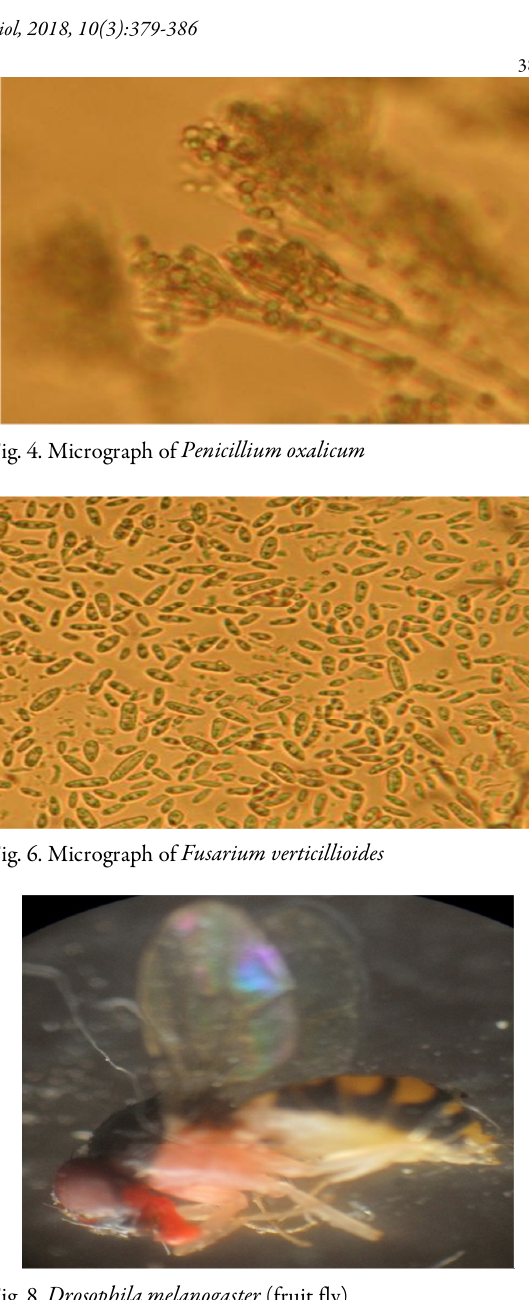
Fig. 8. Drosophila melanogaster (fruit fly)